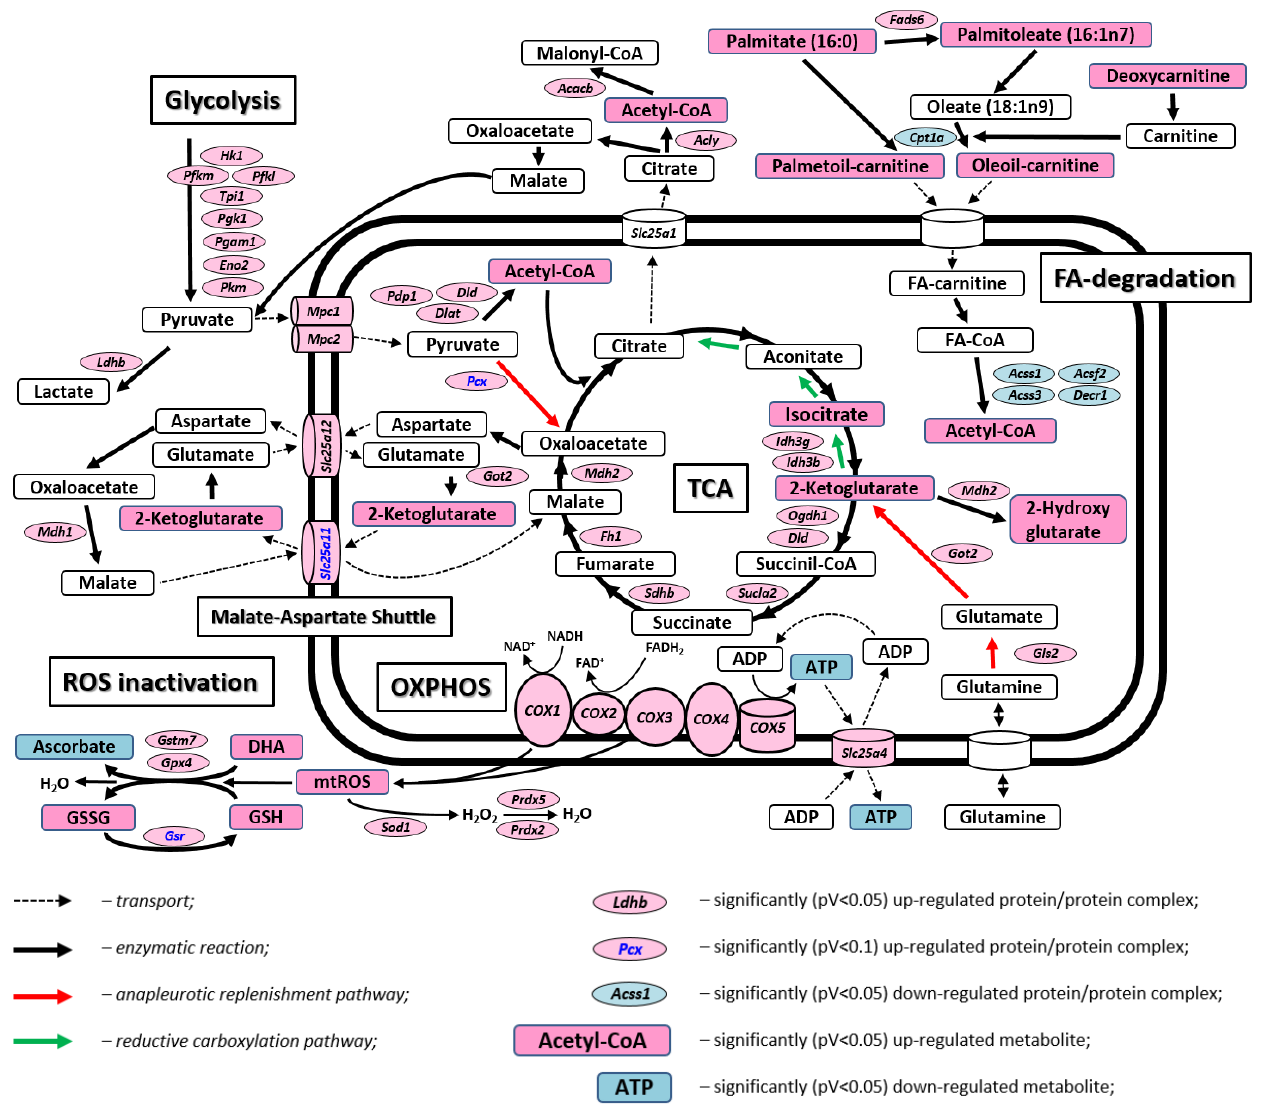
Figure 3. Scheme of the mitochondria-associated metabolic pathways affected in mouse brain by mutation MRPS5 V338Y .